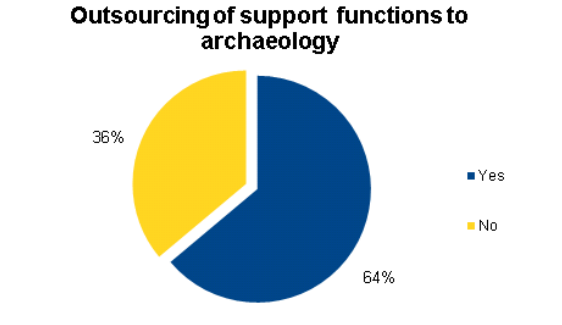
Figure 22 - Shortage of skills in the support functions to